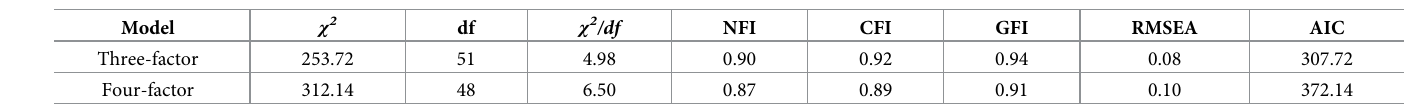
Table 4. Model fit indices.